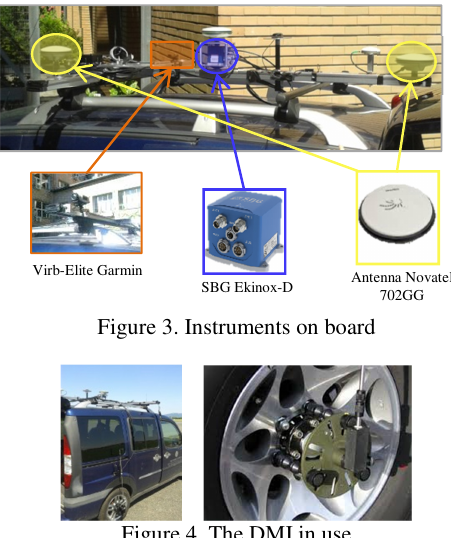
Figure 4. The DMI in use